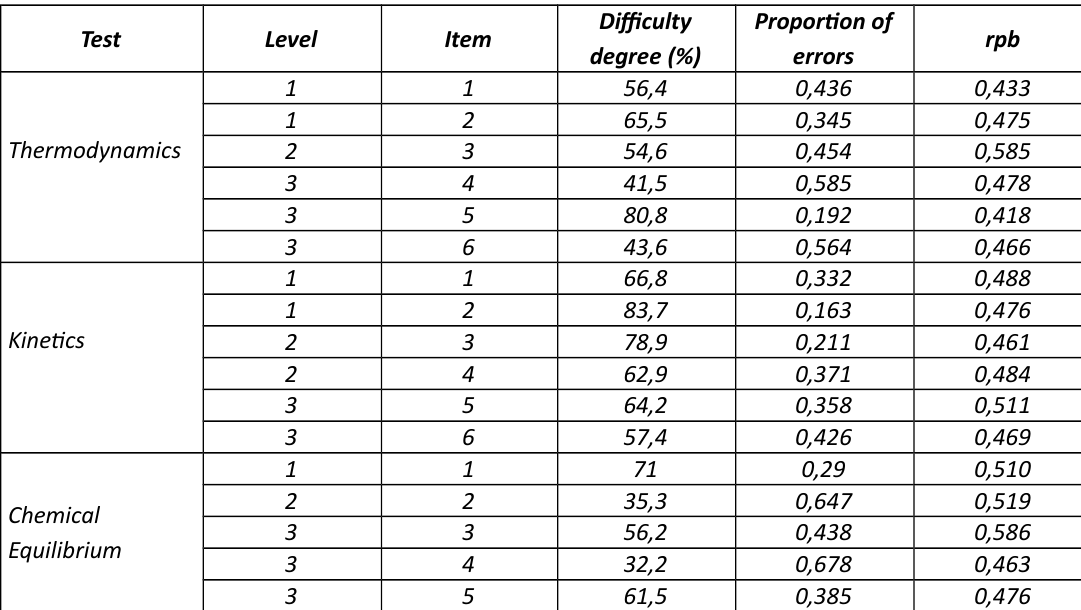
Table 4. Summary of the results of analysis of items for each